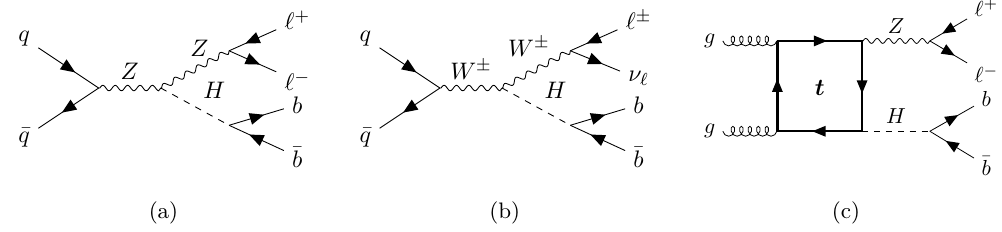
Figure 1 . Sample Feynman diagrams for V H production in the H → b ¯ b decay channel with (a,c) V = Z and Z → ‘ + ‘ − and (b) V = W ± and W ± → ‘ ± ν ‘ , where by ν ‘ we indicate generally a neutrino or anti-neutrino. Panels (a) and (b) are tree-level diagrams in the quark-annihilation ( q ¯ q ) channel at LO, while panel (c) shows a loop-induced diagram in the gluon-fusion ( gg ) channel entering at NNLO